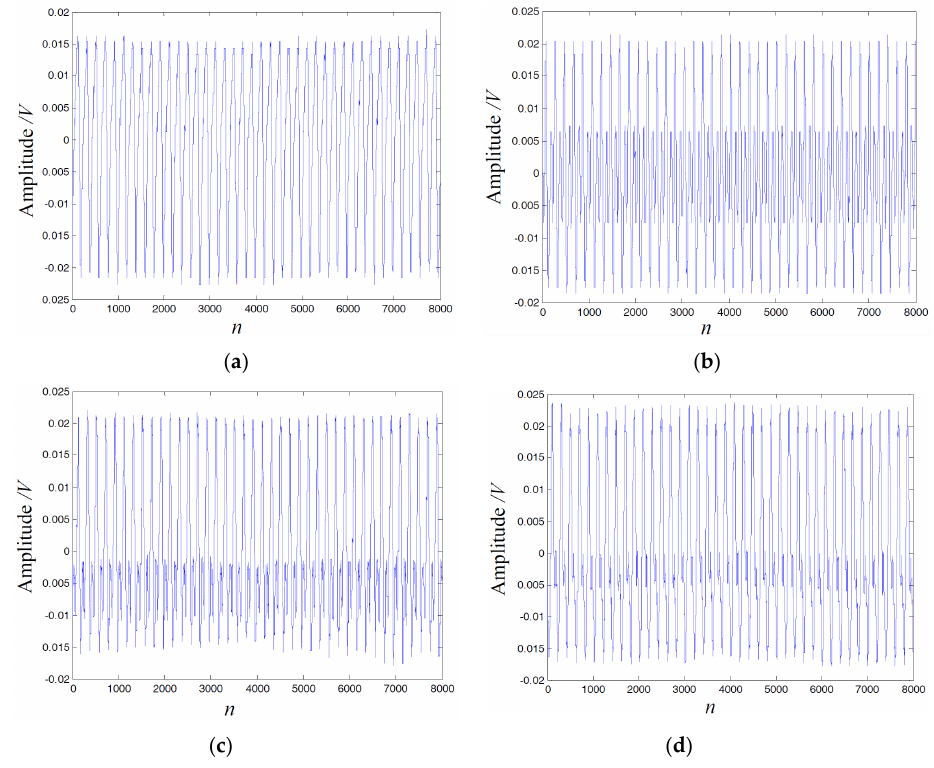
Figure 11. The measured signals with different kinds of faults. ( a ) The measured signals with unbalance fault; ( b ) the measured signals with misalignment fault; ( c ) the measured signals with rub ‐ impact fault; ( d ) the measured signals with the combination of rub ‐ impact and unbalance fault. Table 6. The different types of faults’ recognition results.